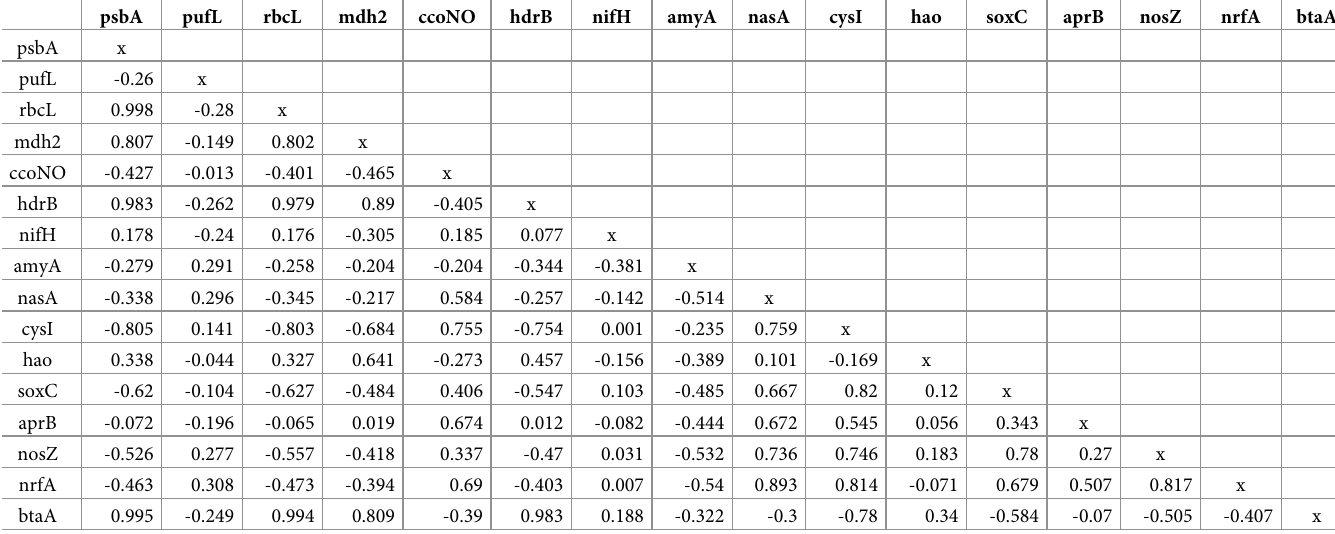
Table 5. Metabolic marker gene correlations (Pearson’s correlation coefficient). Self-comparisons marked